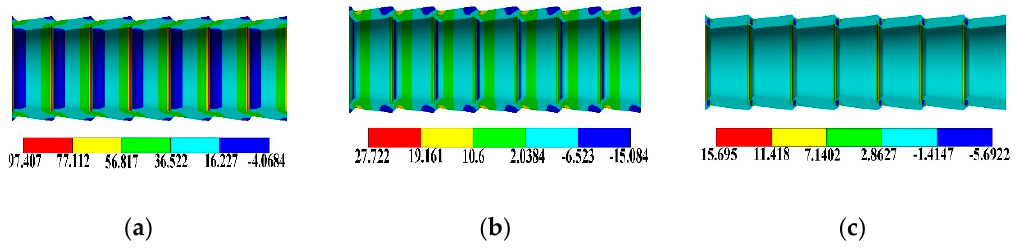
Figure 6. Three-dimensional stress distributions at the CD tubes: ( a ) Axial stress, ( b ) Circumferential stress, ( c ) Radial stress.